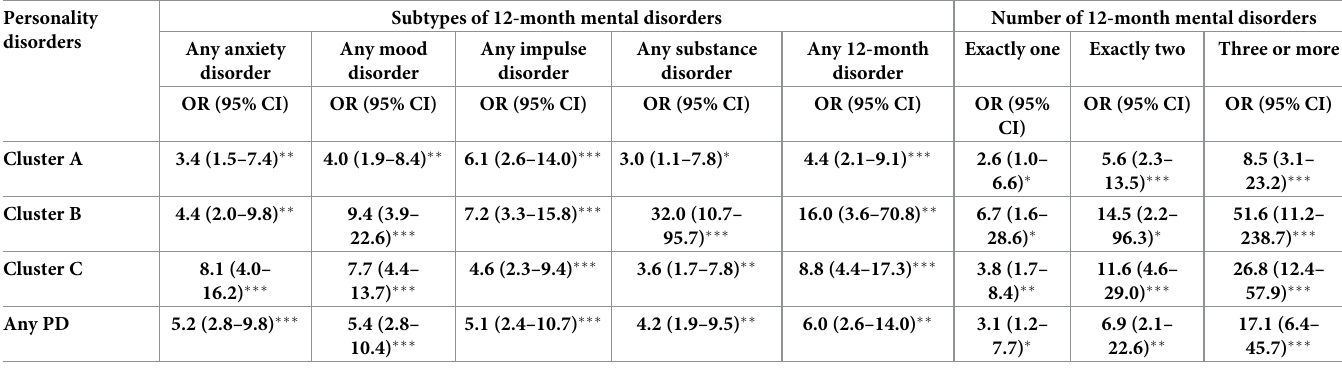
Table 5. Associations of personality disorders with other 12-month mental disorders in the Sao Paulo Metropolitan